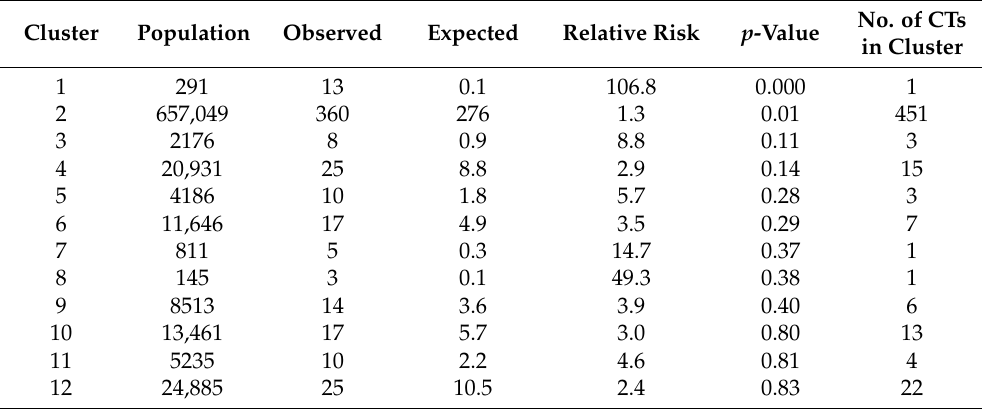
Table 2. Summary of clusters of pediatric brain tumor, Texas,